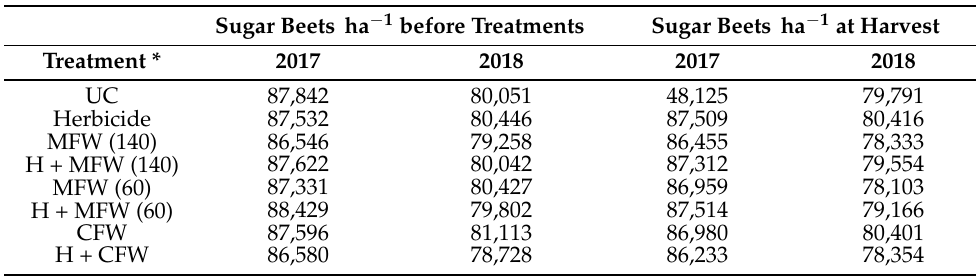
Table 7. The number of sugar beets per hectare before the application of the treatments (crop emergence) and at the harvest date in 2017 and